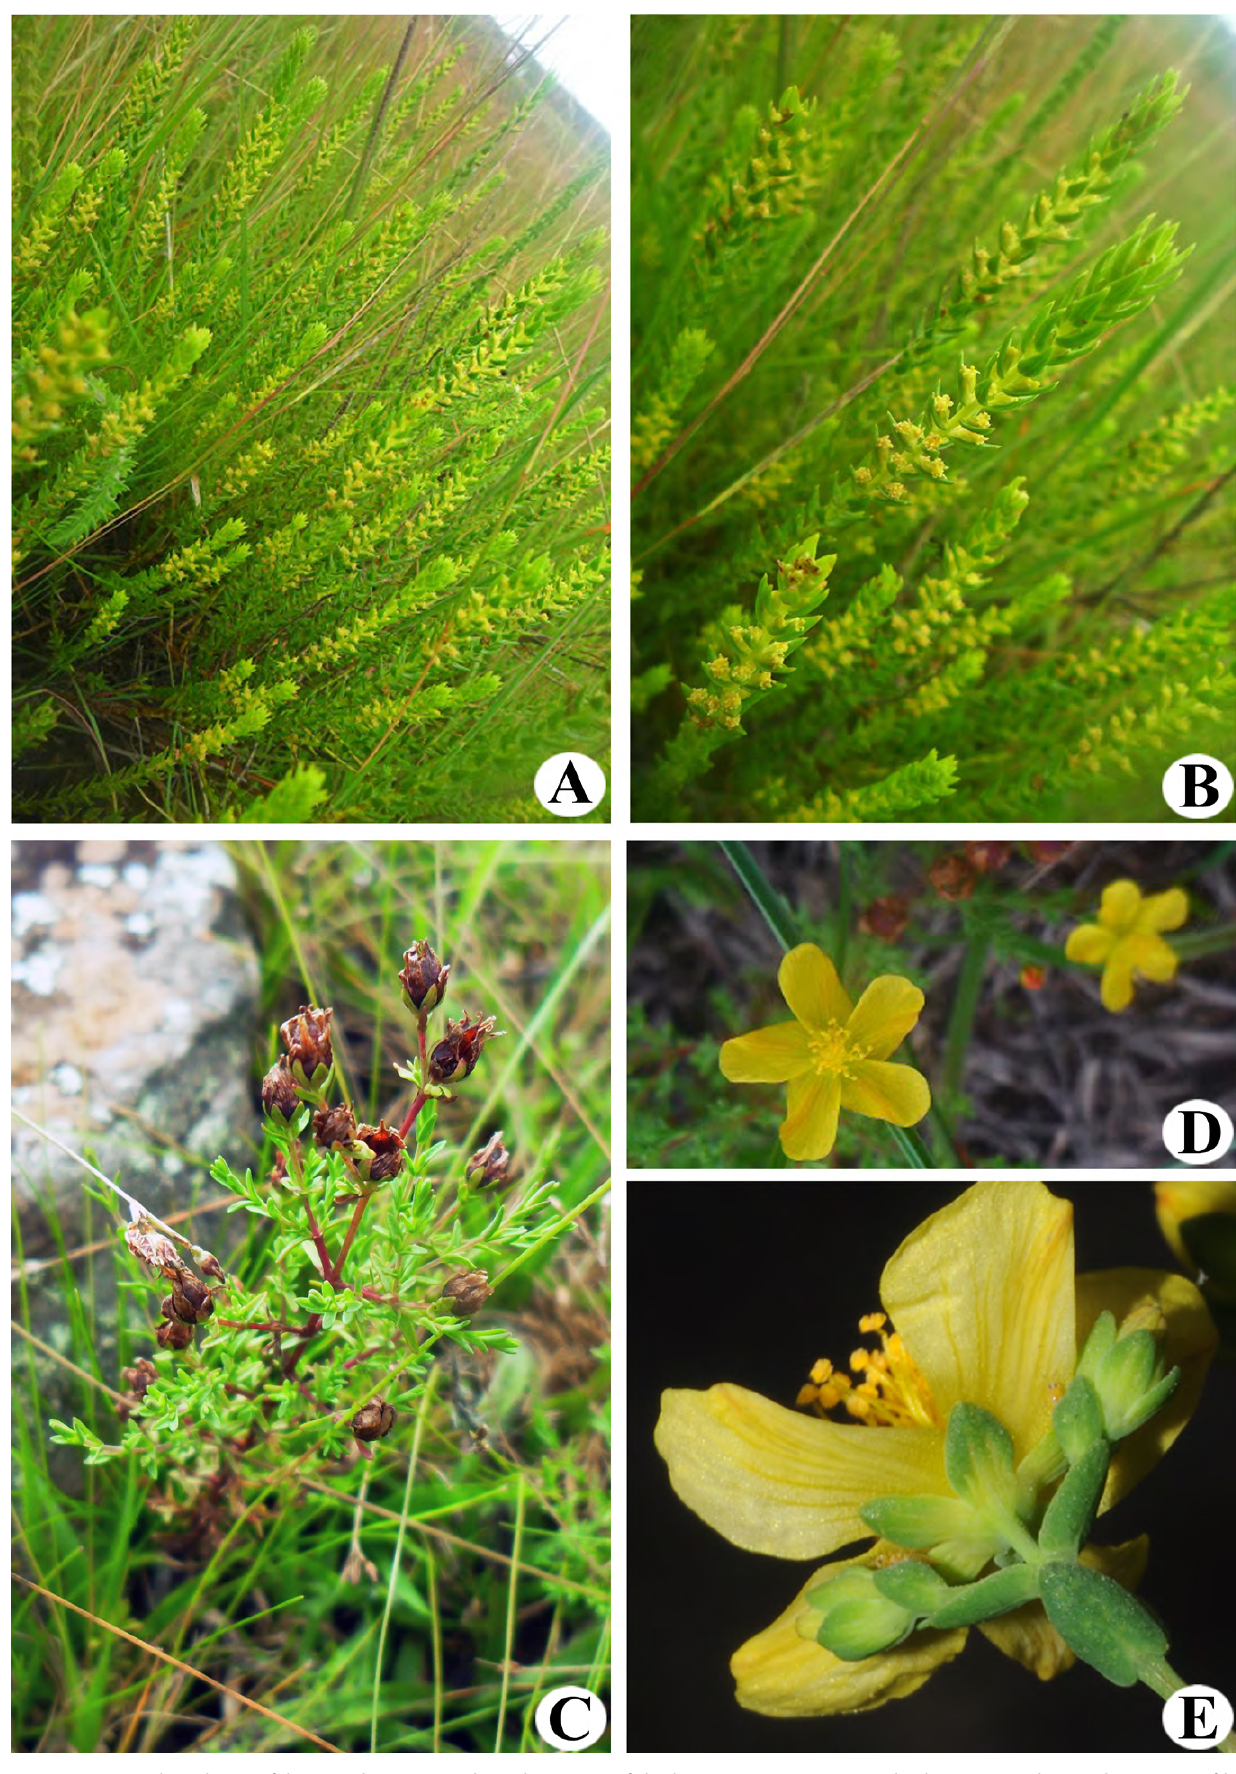
Figure 1. A –B. Baccharis hypericifolia . A. Habit. B. Capitula in the armpit of the leaves. C–E. Hypericum salvadorense. C. Habit. D. Flower. E. Leaf base subcordate. (Photos A, B and D by K. Helmicki, C by C.V. Ely and E by S.A.L.